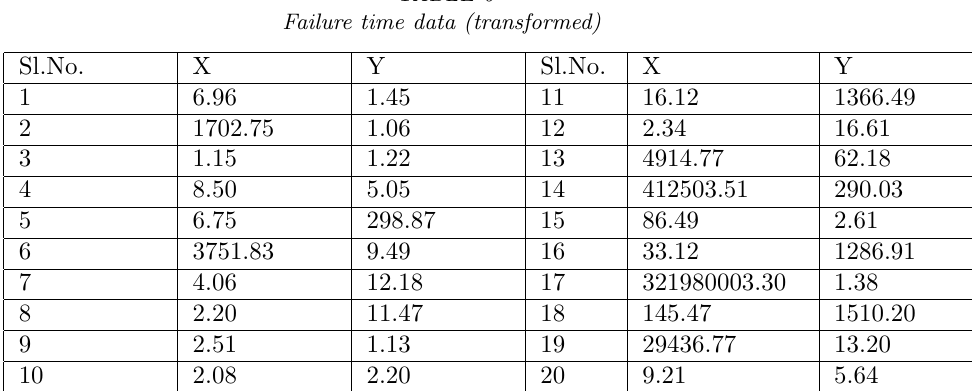
Failure time data